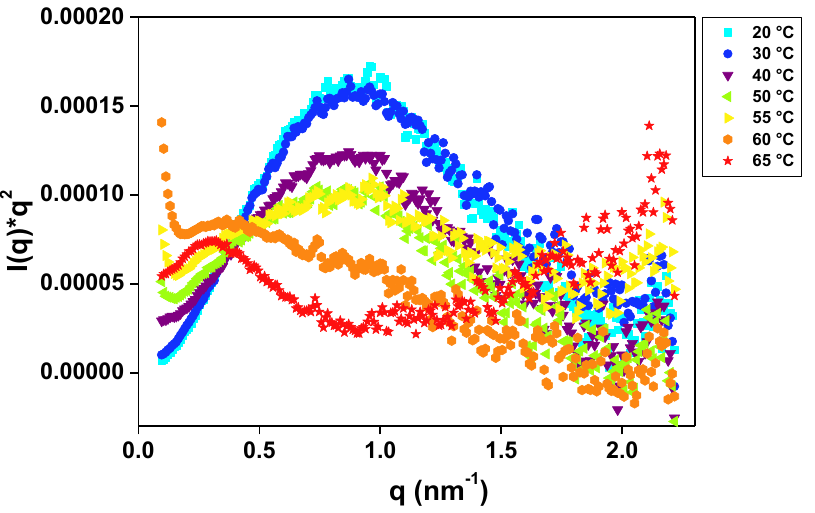
Figure 4. Kratky profile [ I ( q )* q 2 × q ] for GtCel12A in 50 mM sodium citrate